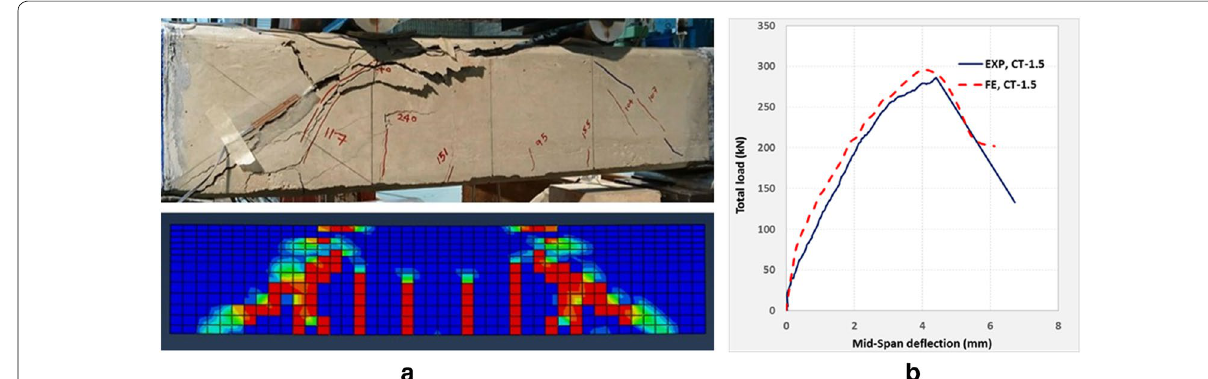
Fig. 20 Control beam (CT‑1.5): a failure mode, b load–deflection response.